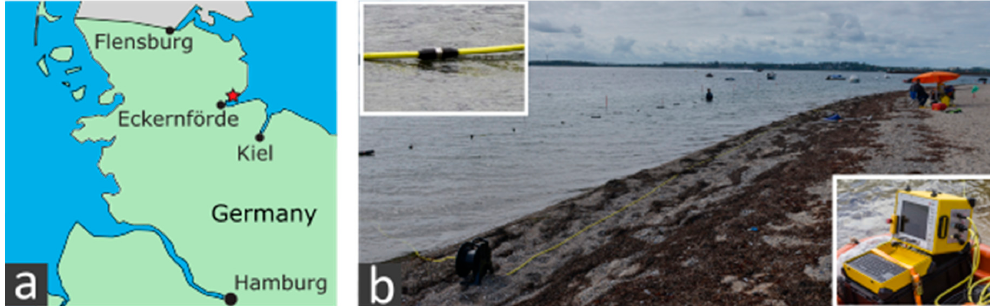
Figure 2. ( a ) Location of Eckernförde Bay in Germany, ( b ) profile using setup F in Eckernförde Bay, Baltic Sea, Germany. Ranging poles mark the profile of 40 m length in which the 20 m long, inverse Schlumberger multi-electrode streamer is positioned. The RESECS (Resistivity Electrode Control System) multi-channel geoelectric unit [13] and stainless-steel electrodes are shown in detail. Table 1. Inverse Schlumberger configuration used for Eckernförde repetition measurements. Electrode Pair